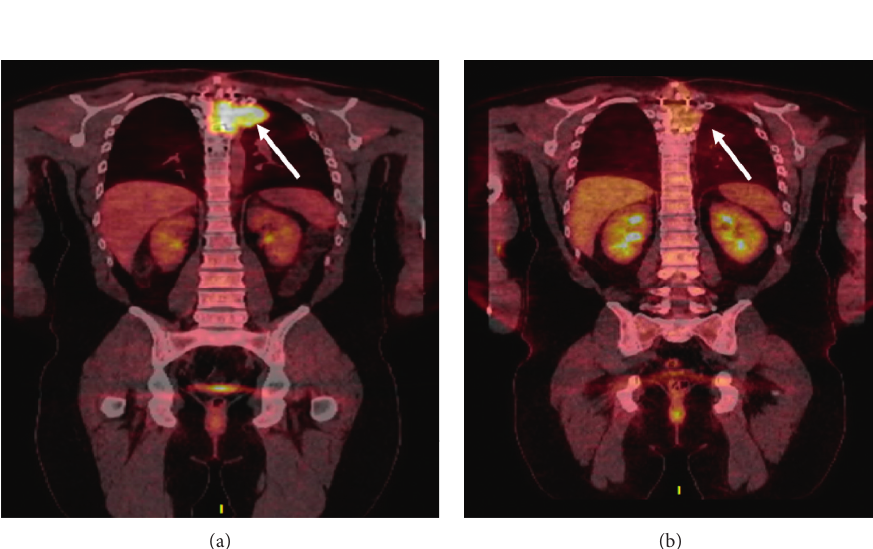
Figure 1: (a) 18F FDG PET-CTat relapse showing large soft-tissue mass replacing the T4 vertebral body (white arrow). (b) 18F FDG PET- CTafter 2 cycles of KRD-PACE showing near-complete resolution of the extraosseous soft-tissue component involving patient’s known T4 vertebral body lesion (white arrow).